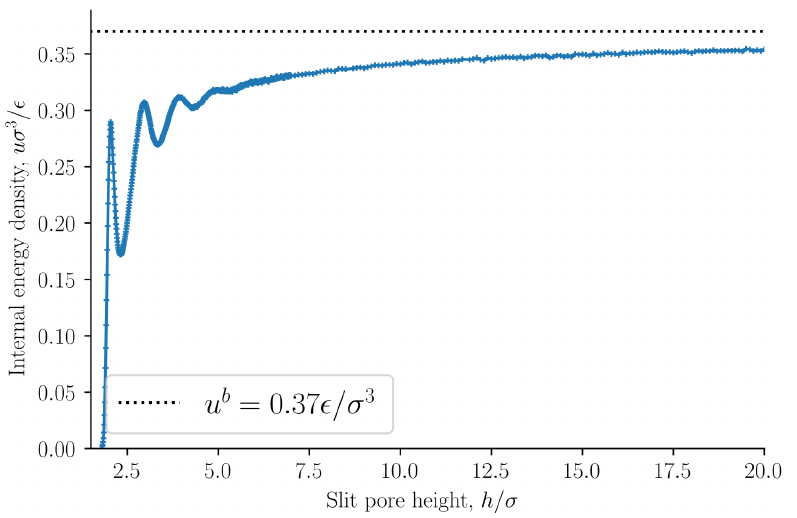
Figure 4. Entropy density s = S / V as a function of slit pore height h . See Equation (36). The dashed line shows the entropy density of the bulk s b .